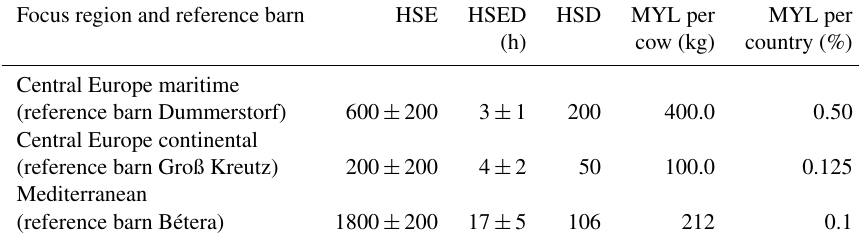
Table 6. The number of heat stress events (HSE) and their average duration (HSED) based on the projections under RCP 8.5 were considered. The number of heat stress days (HSD) was estimated as the ratio HSE/HSED assuming one period of consecutive heat stress hours per day. Milk-yield loss (MYL) per country was extrapolated for the countries where the reference barns are located and given relative to a reference milk yield. The assumed total amount of cows was 4 . 2 × 10 6 in Germany and 0 . 8 × 10 6 in Spain (2017 level according to http://de.statistica.com/). For Germany half of the cows were allocated to the projected change for the reference barn Groß Kreutz and the other half to the reference barn Dummerstorf. A reference annual European milk yield of 168 × 10 6 t was assumed (see the Introduction